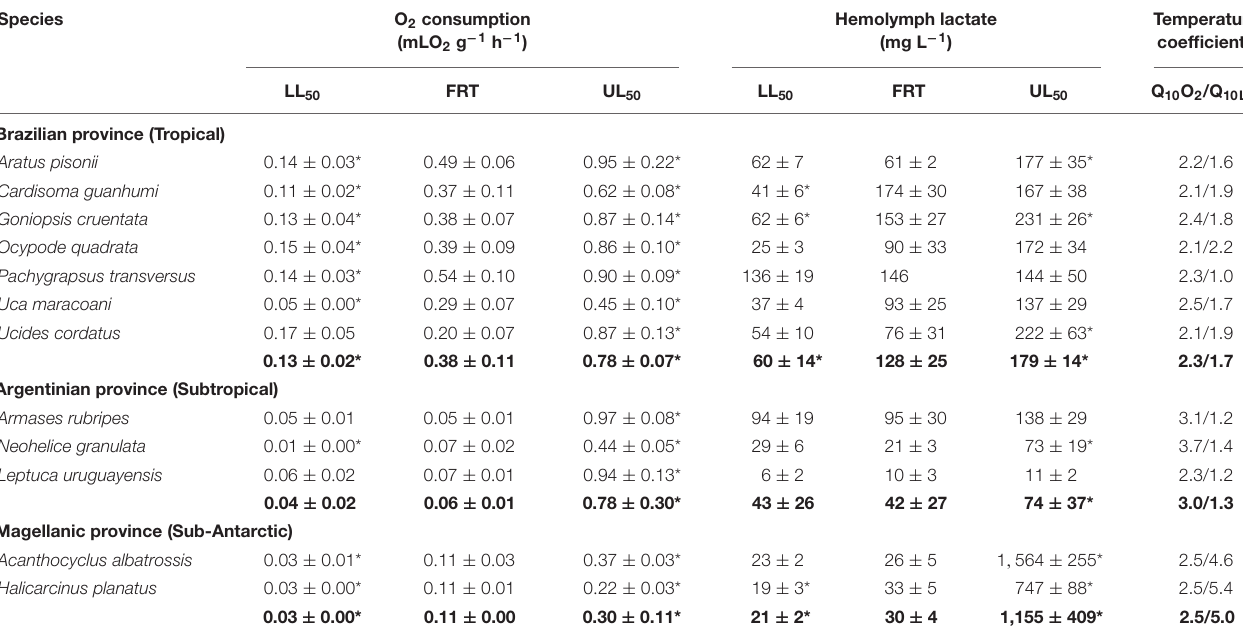
TABLE 2 | Crab species and their systemic physiological parameters, mass-specific oxygen consumption rate (mL O 2 g − 1 h − 1 ) and hemolymph lactate concentration (mg L − 1 ), measured at their respective field reference temperatures (FRT) and lower (LL 50 ) and upper (UL 50 ) critical thermal limits.